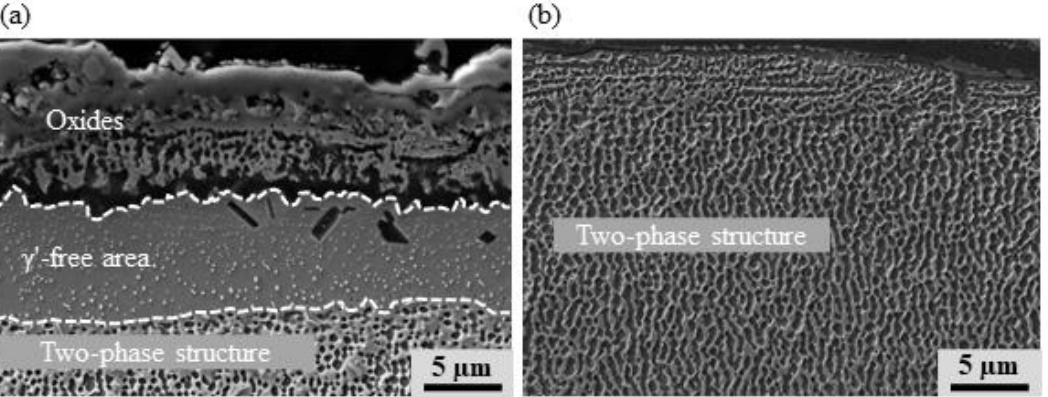
Figure 5. Microstructure after creep deformation at 980 °C and 230 MPa ( a ) in air after 50 h and ( b ) under vacuum after 75 h.